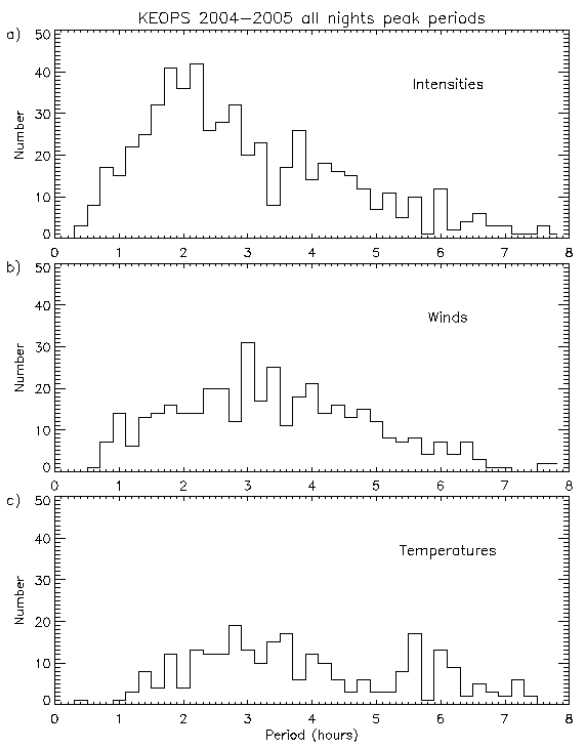
Fig. 12. Histogram of gravity wave periods for all nights from KEOPS data from the north, east, south, and west directions, over the winter season of 2004–2005: (a) intensities, (b) winds, and (c)